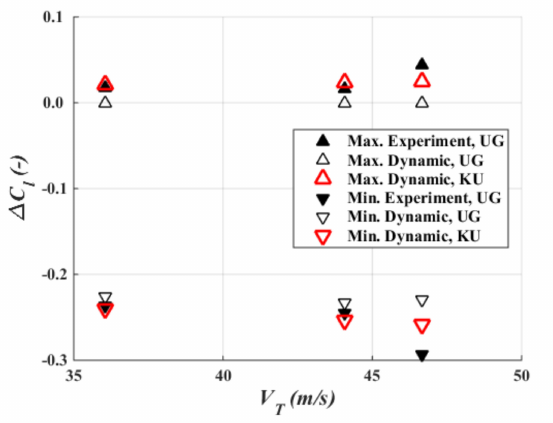
Figure 8. Maximum and minimum deviations in the lift coe ffi cient at η B = 75%, C d = 1.2.